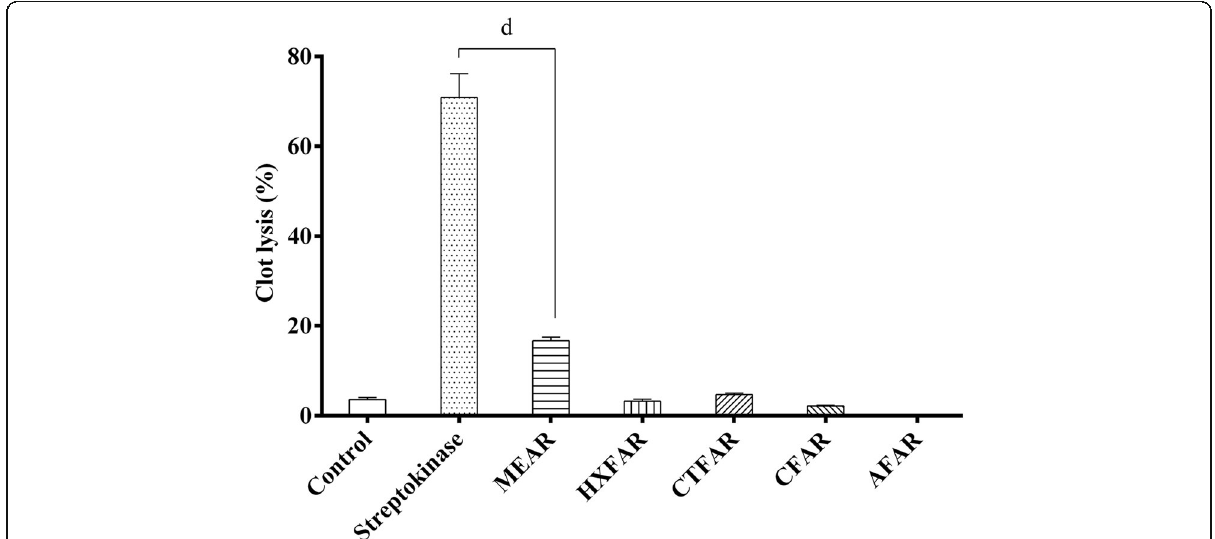
Fig. 3 Thrombolytic activity of different extractives of stem of Albizia richardiana on human blood. Values are represented in Mean ± SEM (n = 3). d P < 0.0001 considered as statistically significant in comparison to control